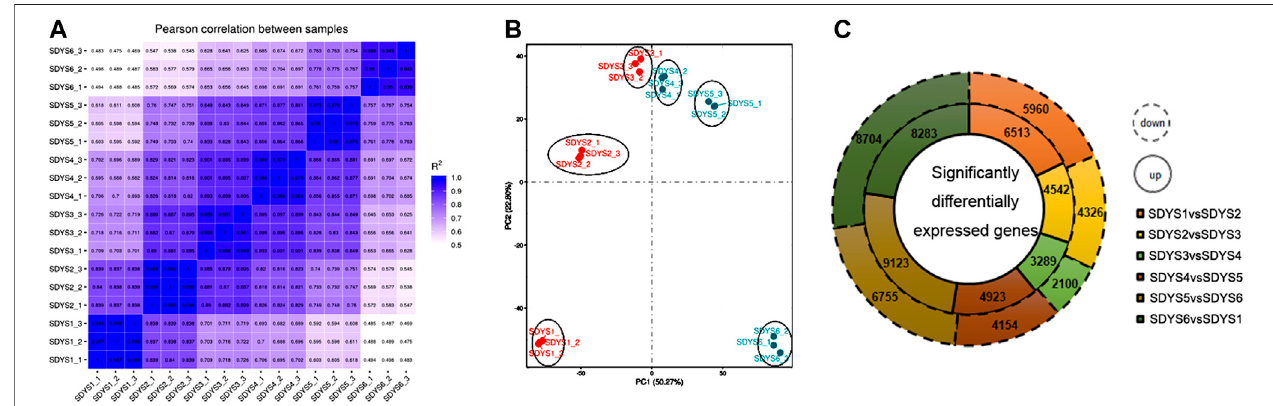
FIGURE 2 | Transcription during embryonic development of P. mongolica . (A) Correlation analysis among all samples. (B) Principal component analysis of the transcriptomes of samples from six stages. (C) Differentially expressed genes in each stage.